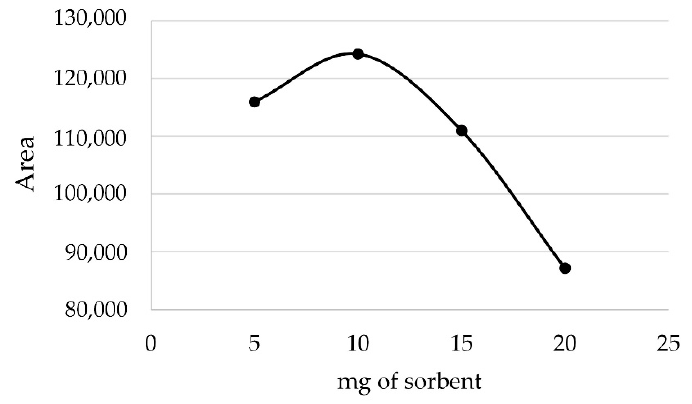
Figure 2. Effect of mg of sorbent on the area obtained by the analytes under study. Sample loading volume. With 10 mg of sorbent, the sample loading volume